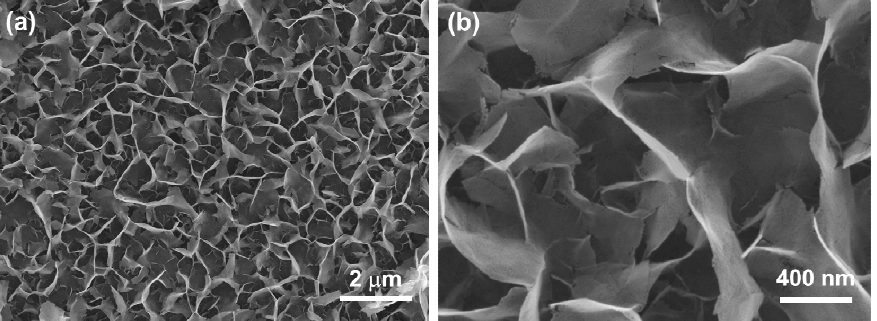
Figure 2. SEM images of ( a ) the three-dimensional nanostructure of N-doped NiO NSs and ( b ) its magnified image.